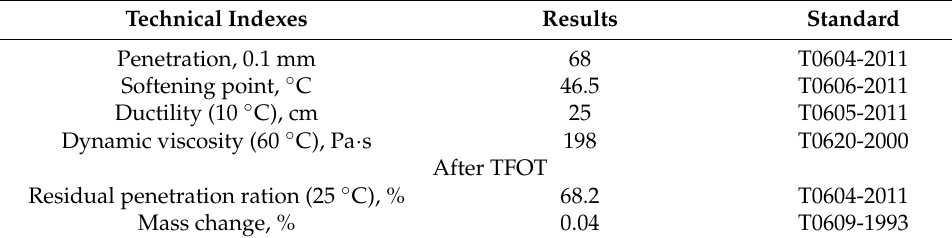
Table 1. Technique properties of 70# virgin asphalt.